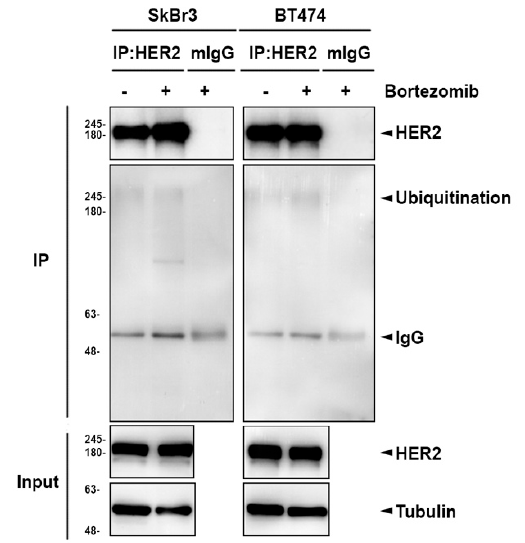
Figure 7. The ubiquitination of HER2 was increased in response to bortezomib. BT474 and SkBr3 cells were treated with 0.1 μ M bortezomib for 24 h. HER2 then was immunoprecipitated for detection of protein ubiquitination with anti-ubiquitin antibody.